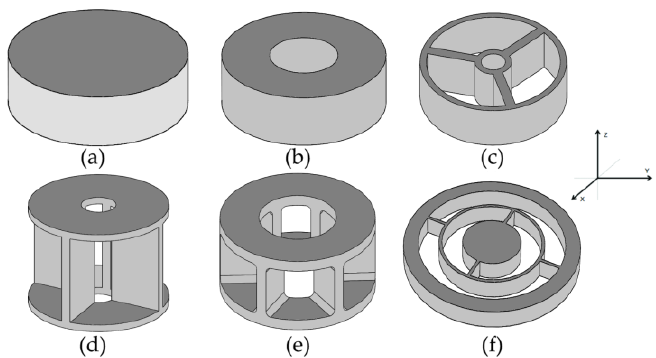
Figure 3. Types of torque sensor structures with gauges: ( a ) Solid Cylinder, ( b ) Hollow Cylinder, ( c ) Hub-Sprocket ( d ) Hollow Cruciform, ( e ) Hollow Hexaform, ( f ) Spoke Topology. Adapted from [2].